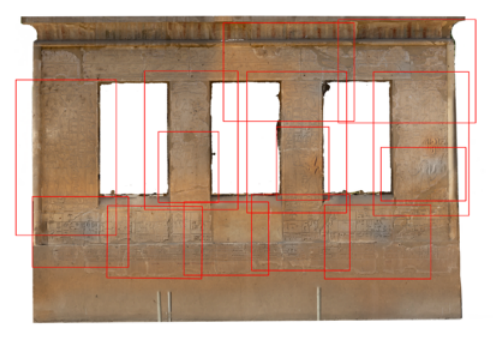
Figure 11 . Orthophotography with location of archives.